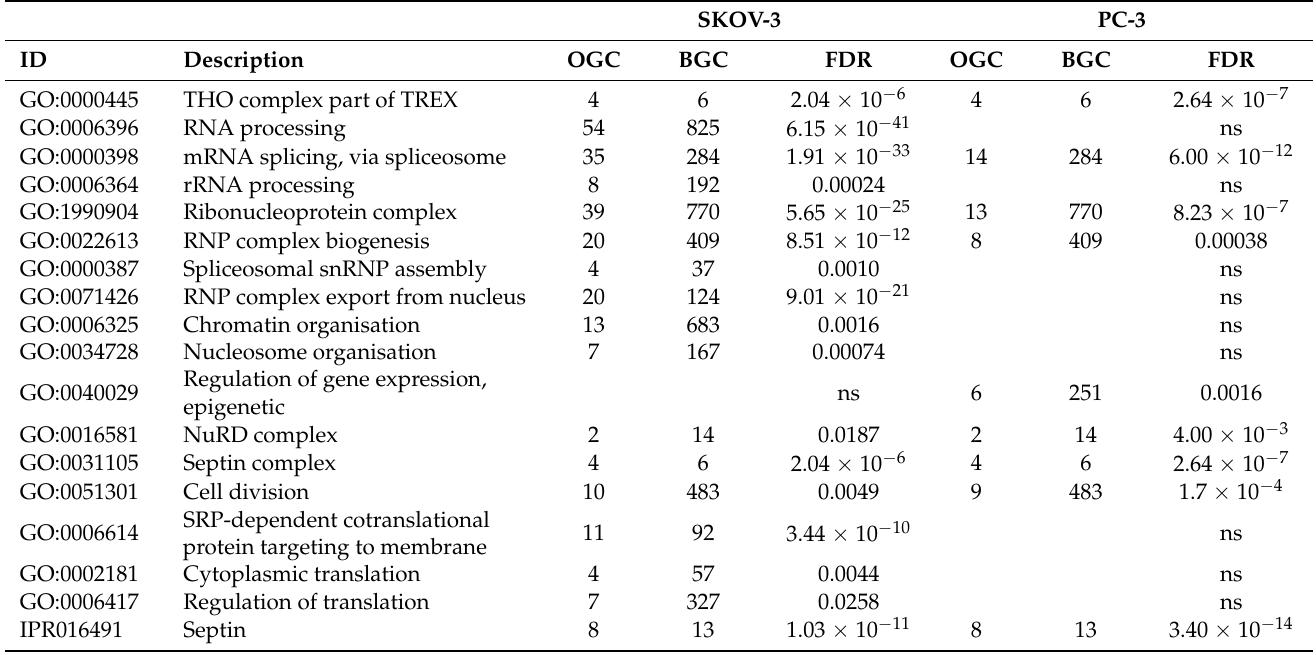
Table 1. GO term enrichment analysis of the whole lysate in HMGB1-interactomes in SKOV-3 and PC-3 cells. (OGC, observed gene count; BCG, background gene count; FDR, false discovery rate; ns, not statistically significant).